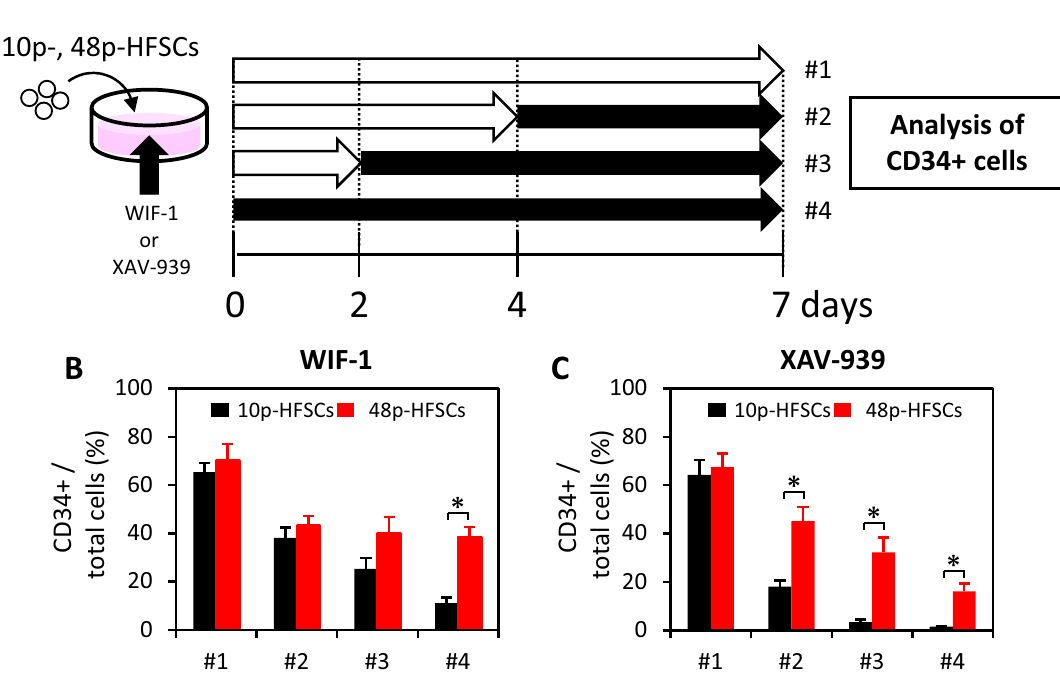
Figure 7. Changed responsiveness to Wnt signal inhibitors in HFSCs passaged with M-CnT for long term. ( A ) Schedules of experiments for determining responsiveness of HFSCs passaged with M-CnT for long term to Wnt signal inhibitors. Flow cytometry was used to examine CD34-immunopositivity in 10p- and 48p-HFSCs cultured with M-CnT after treatment without or with a Wnt signal inhibitor (WIF-1 or XAV-939) on Day 0, 2, and 4 (#4, #3, #2, #1, respectively). ( B ) Analysis of CD34-positive cells among 10p- and 48p-HFSCs cultured with WIF-1. * p < 0.05. ( C ) Analysis of CD34-positive cells among 10p- and 48p-HFSCs cultured with XAV-939. * p <